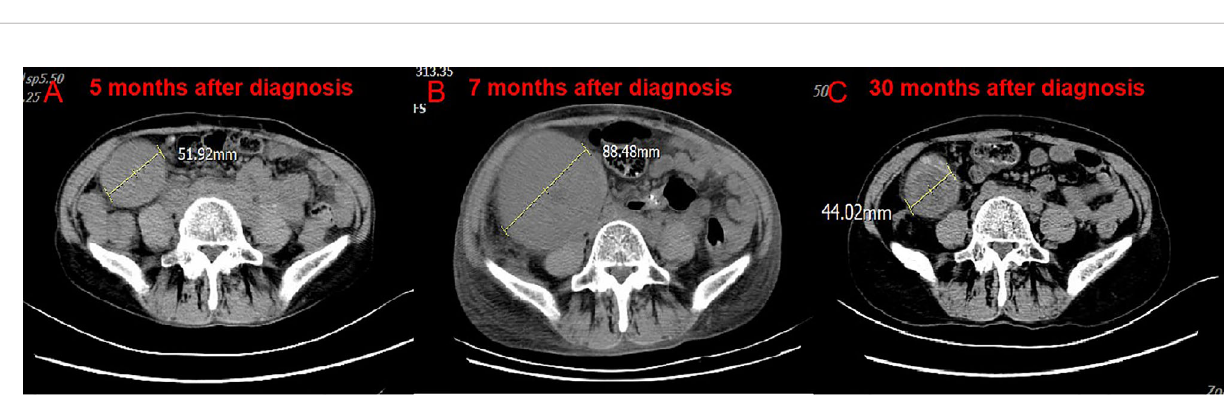
FIGURE 3 | CT scan of the volume of transplanted kidney.Compare CT of April18, 2019 (B) with February 20, 2019. (A) The volume of transplanted kidney increased after treatment ofnivolumab.CompareCT of March 2, 2021 (C) with April18, 2019. (B) The volume oftransplanted kidney decreased after nivolumab